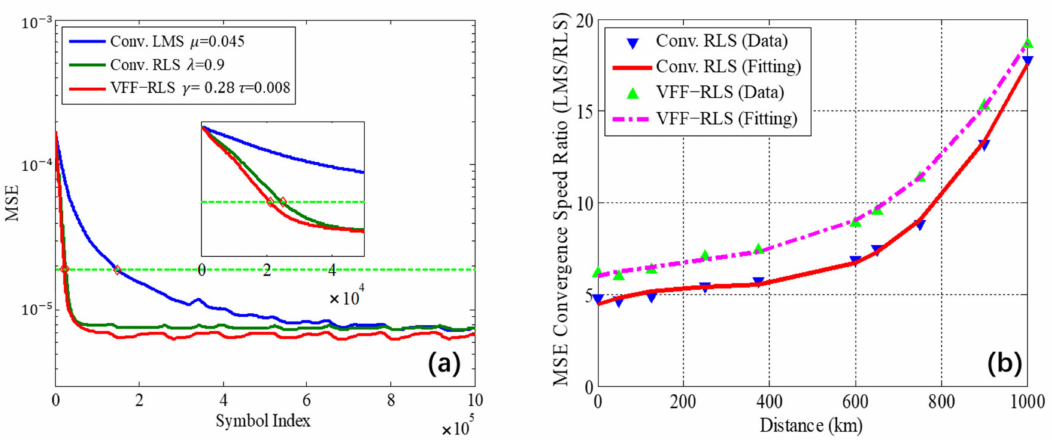
Figure 5. Convergence speed comparison between VFF-RLS/RLS and LMS: ( a ) MSE convergence at 600-km vs. symbols; ( b ) Ratio of convergence speed of LMS and VFF-RLS/RLS vs.